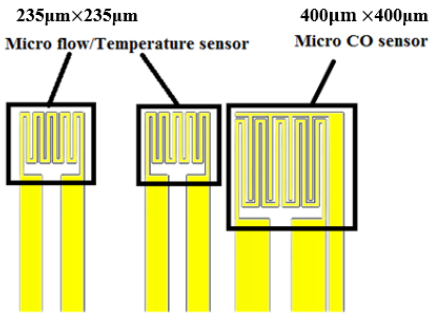
Figure 3. Design drawing of flexible integrated microsensor.